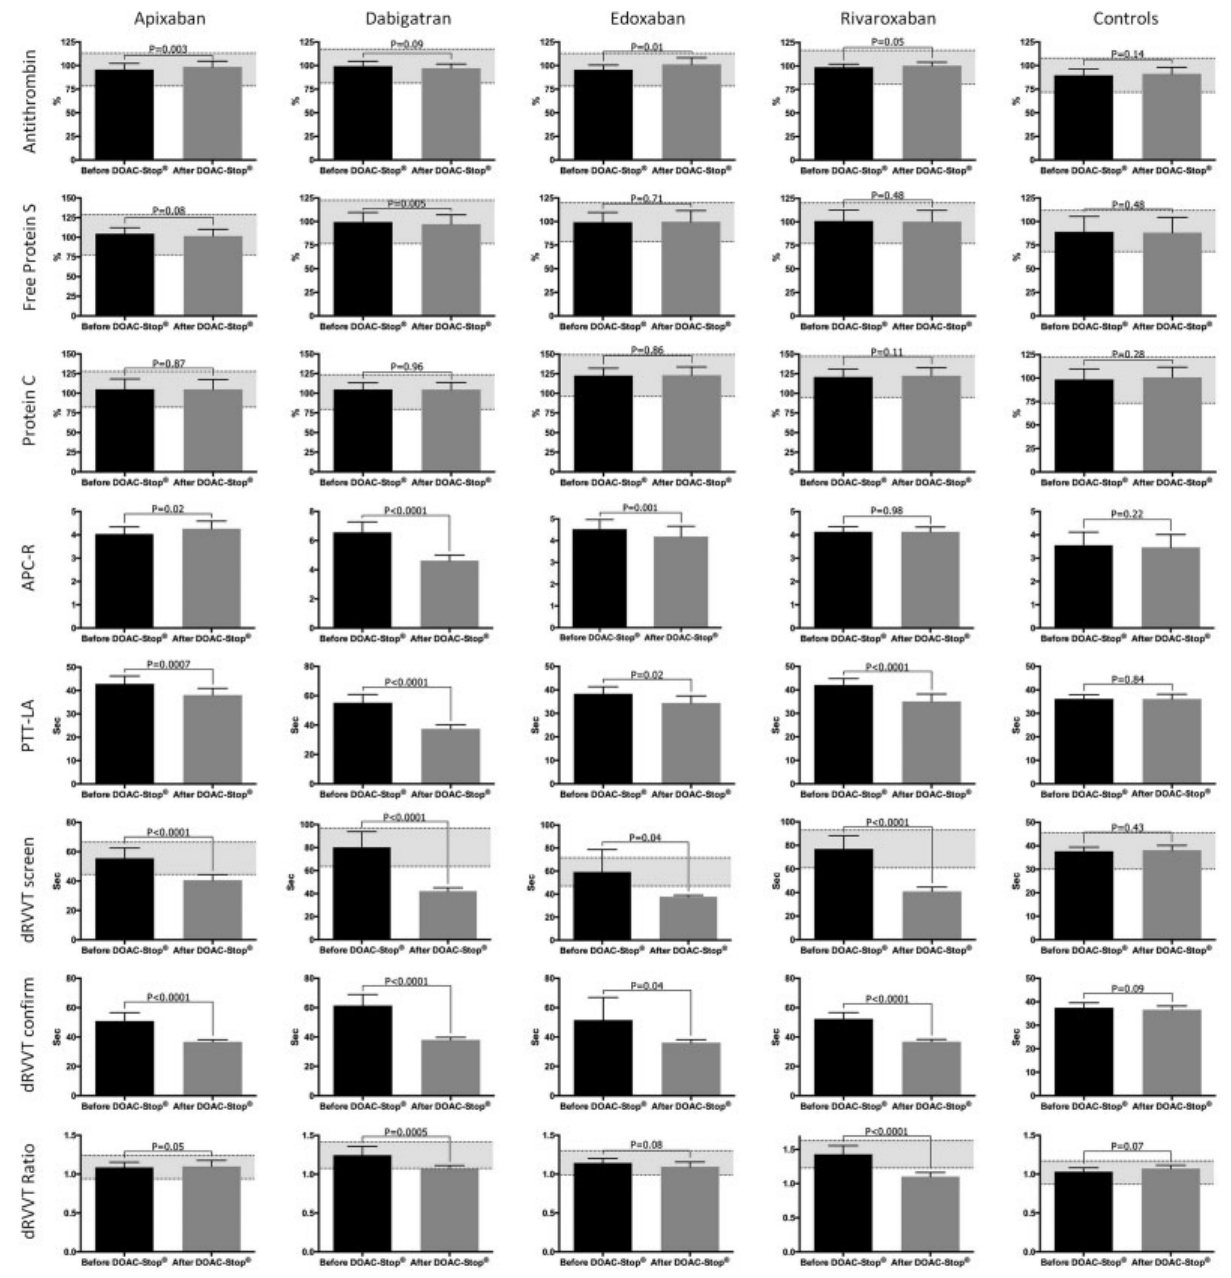
Fig. 2 Impact of the DOAC-Stop ® adsorbent treatment on common thrombophilia screening tests. The gray zone corresponds to the reference change value interval of each test. The mean (and 95% con fi dence interval) of each parameter is presented before and after the DOAC-Stop ®